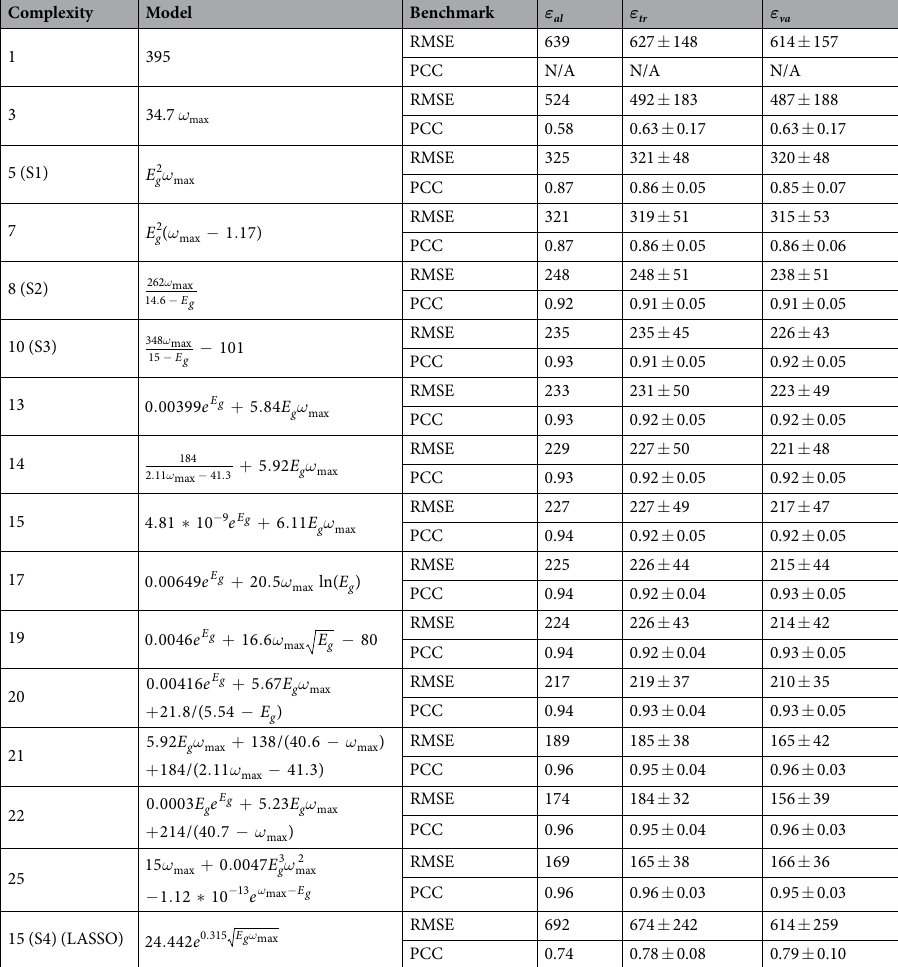
Table 2. The performance in predicting dielectric breakdown strength on all data ε al , training data ε tr , and validation data ε va for models on the universal Pareto frontier constructed using training, validation, and test data.